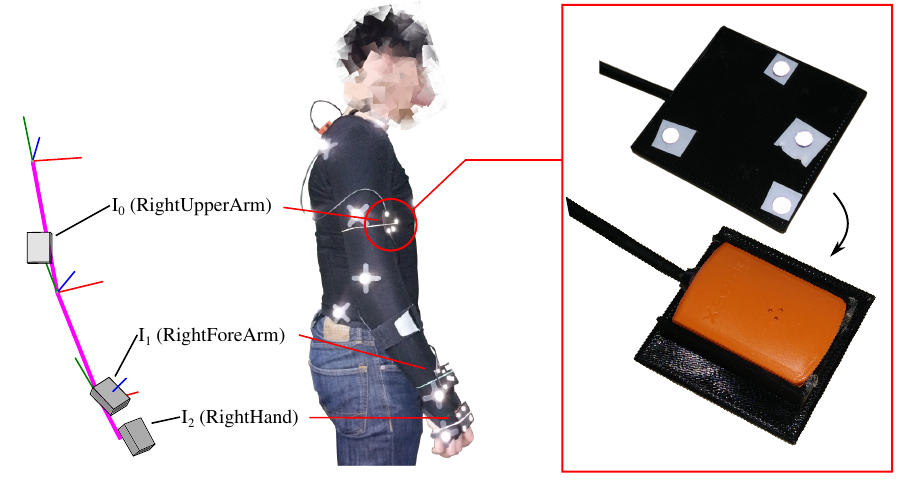
Figure 2. Capturing setup for the real data scenario. In the picture on the left, the segment coordinate systems are associated to the proximal ends of the segments. Note, the axes are orthogonal and only roughly aligned with the anatomical axes of rotation through the skeleton fitting of the optical system as described in Section 2.6.1. Precise alignment with the anatomical axes was not in the focus of this study. In the N-pose, for the right arm, the x -axes are chosen perpendicular to the frontal plane pointing anterior, the y -axes are perpendicular to the transverse plane pointing along the segments in the direction from the distal to the proximal ends and the z -axes are perpendicular to the sagittal plane pointing lateral. The picture also indicates the initial arm configuration for real-slow and real-fast